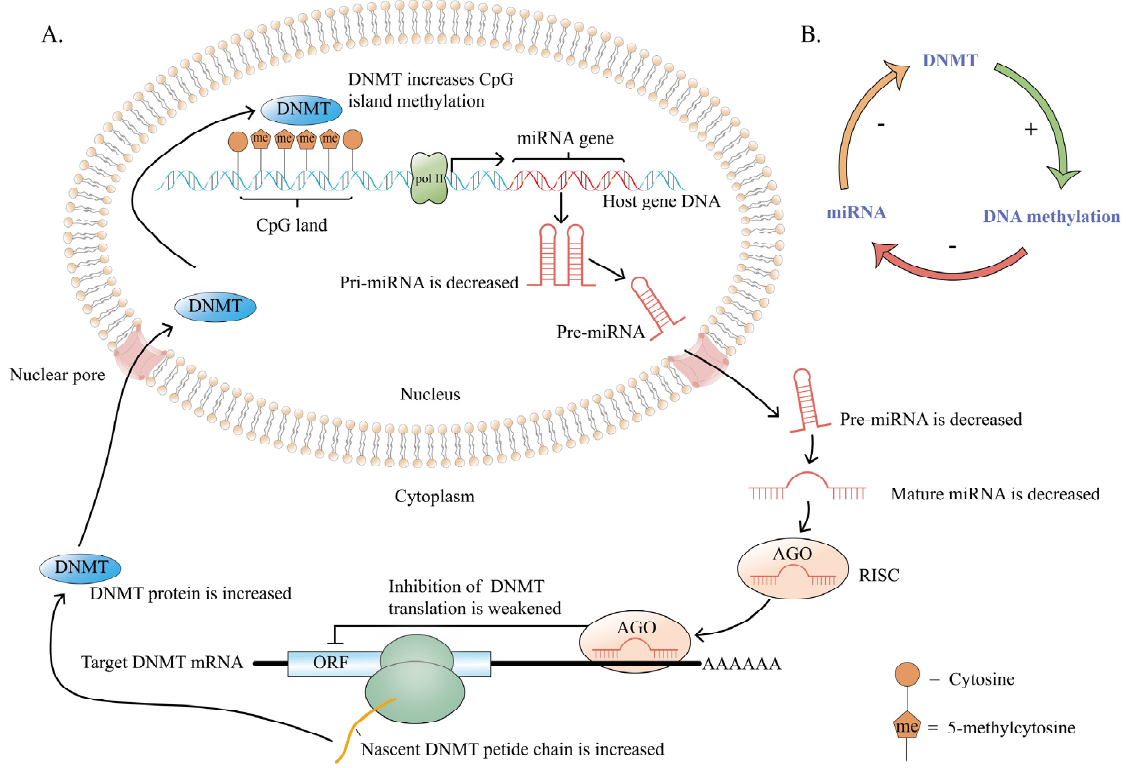
Figure 3. The miRNA/DNMT regulatory loop. ( A ). The methylation state of the miRNA host gene promoter is regulated by DNA methyltransferase; miRNAs can target and negatively regulate DNA methyltransferase expression in turn, which can form a regulatory loop involved in the initiation and development of BC. DNMT acts on the CpG island region of the miRNA host gene promoter, causing hypermethylation and inhibiting pri-miRNA synthesis. Pri-miRNA generates pre-miRNA after continuous shearing and exports it to the cytoplasm. Next, pre-miRNA is cleaved to generate mature miRNA. The miRNA and Argonaute (AGO) form a transcriptional silencing complex, which weakens the inhibitory effect on the target DNMT mRNA, subsequently increasing the DNMT pro- tein. Then, DNMT is transported into the nucleus where it increases the methylation degree of CpG islands and further inhibits miRNA expression. A miRNA/DNMT regulatory circuit is formed. ( B ). A brief schematic diagram of the miRNA/DNMT regulatory circuit. Pri-miRNA, primary-miRNA. Pre-miRNA, precursor-miRNA. RISC, RNA-induced silencing complex. ORF, open reading frame. DNMT, DNA methyltransferase.